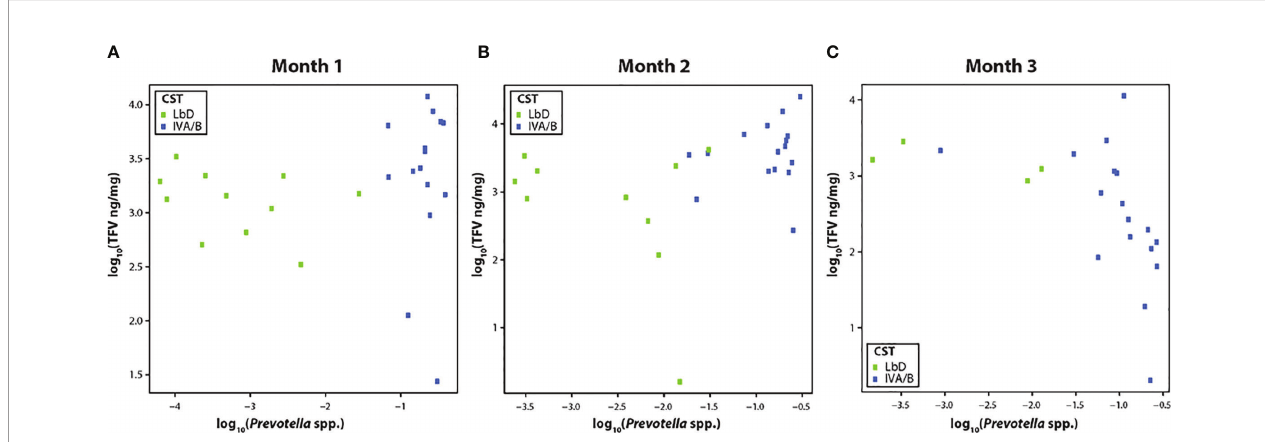
FIGURE 2 | (A – C) Correlation of tenofovir (TFV) vaginal fl uid concentration with the relative abundance of Prevotella species at months 1, 2, and 3. Green dots represent participants who had Lactobacillus-dominated (LbD) vaginal microbiota at the time of sampling and their individual TFV vaginal fl uid concentration and relative abundance of Prevotella species. Blue dots represent participants who had diverse anaerobe dominated (CST IVA/B) vaginal microbiota at the time of sampling and their individual TFV vaginal fl uid concentration and relative abundance of Prevotella